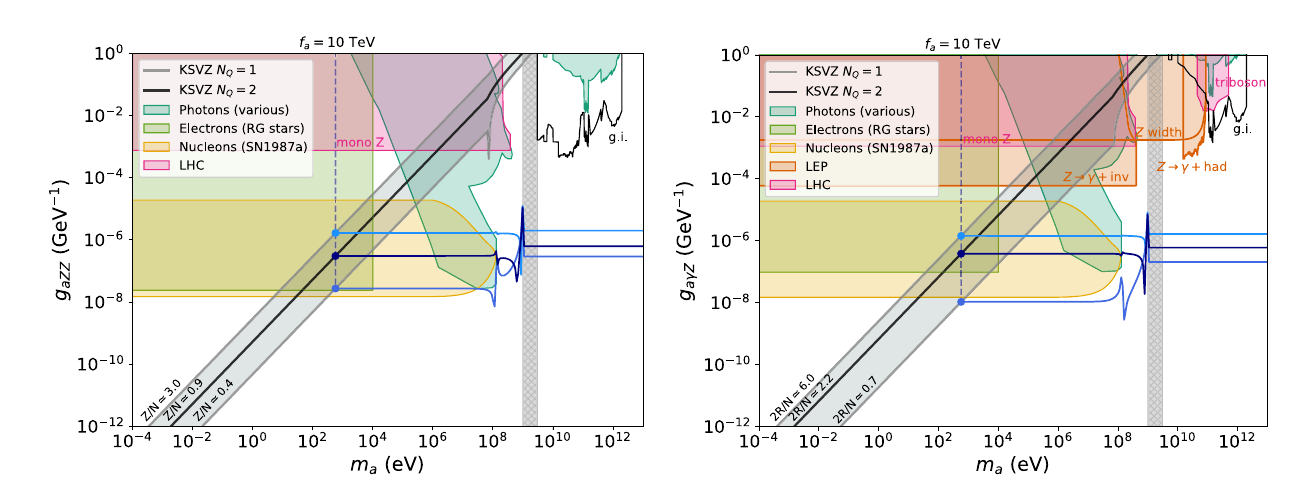
of EW gauge invariance. The superimposed lines correspond to KSVZ- type QCD axion models (black line and grey band) and to one bench- mark heavy axion model with f a = 10TeV (blue lines). The parameter space for heavy axions corresponds to moving up and down that set of blue lines, see Sect. 4.4. The results apply as well to gluonic ALPs (we provide exclusion plots without superimposed lines as auxiliary files)